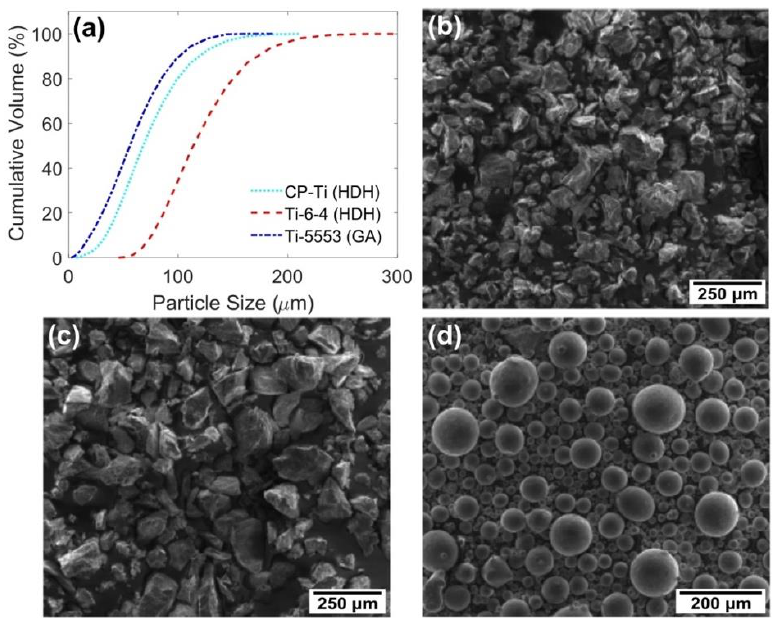
Figure 1. ( a ) Graph showing the PSD of each powder; ( b ) corresponding secondary electron (SE) micrograph of the CP-Ti HDH powder; ( c ) corresponding SE micrograph of the Ti-6-4 HDH powder; and ( d ) the corresponding SE micrograph of the Ti-5553 GA powder.